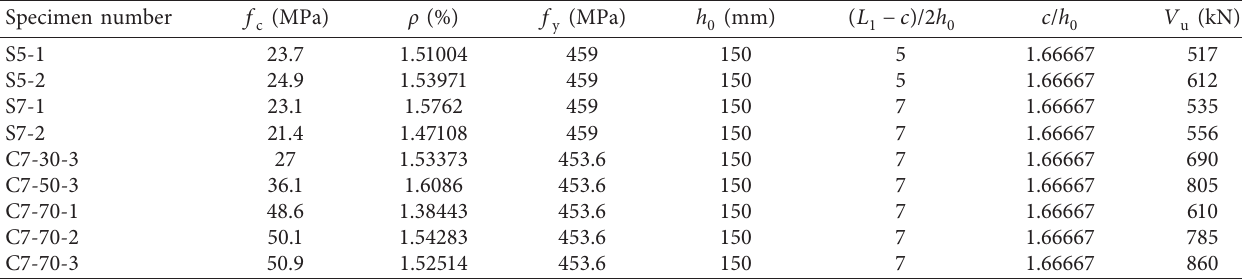
Table 5: Punching test parameters for the slab-column connections.